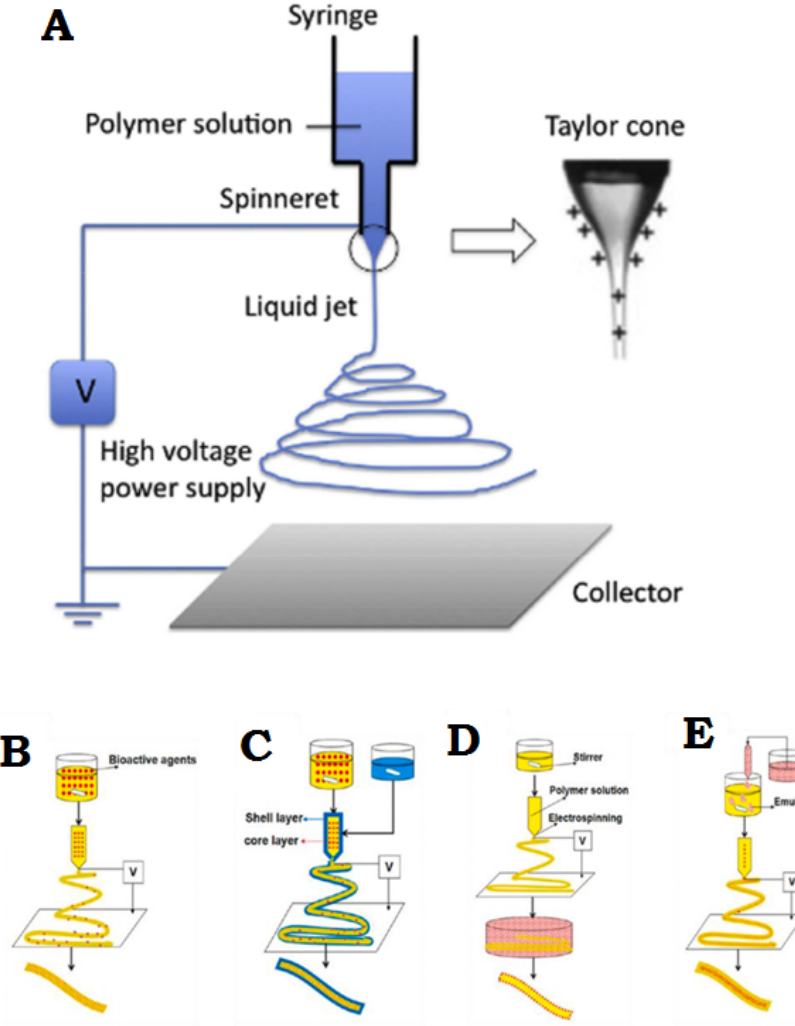
Figure 2. ( A ) General flowchart of the basic electrospinning process. ( B ) Adjusting the electrospin- ning mixture. ( C ) Set up of shell electrospinning. ( D ) Surface functional electrospinning settings. ( E ) Emulsion-based electrospinning operation. ( A ) is reprinted from [30]; ( B – E ) are reprinted from [31] Licensed by the American Chemical Society.